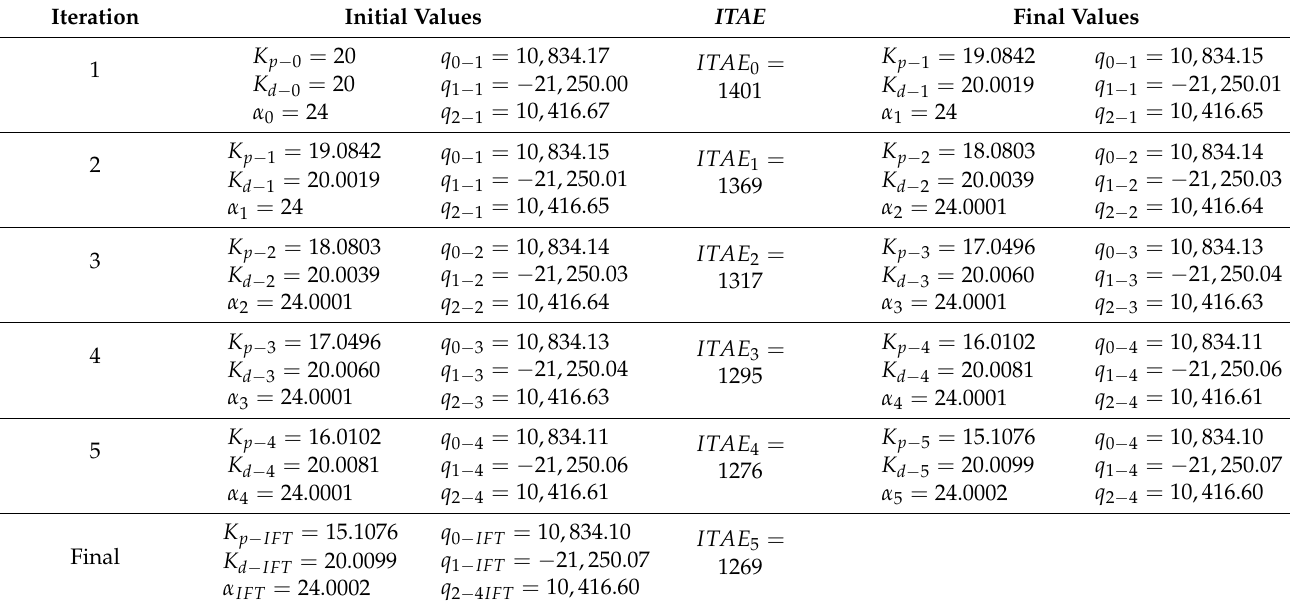
Table 3. Tuning parameters for the iPD 2 controllers and the ITAE criteria values.